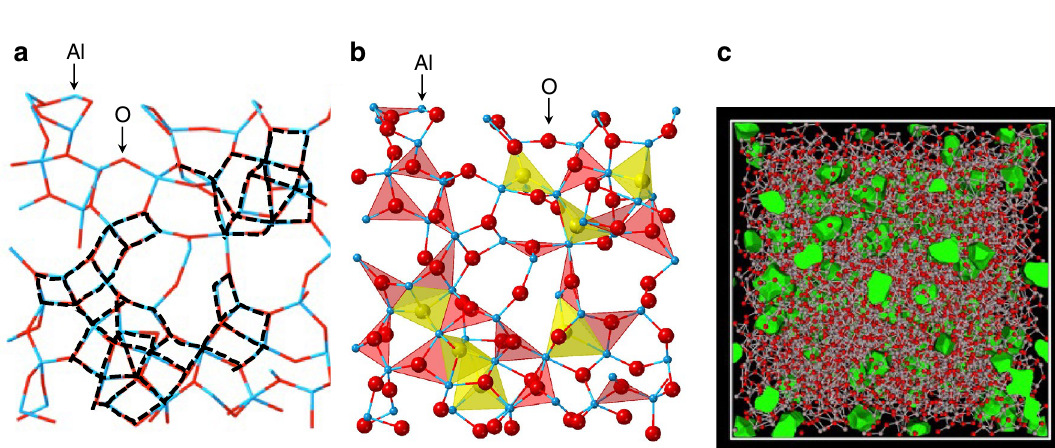
Figure 6. ( a ) Atomic configuration of g -Al 2 O 3 (stick bonds schematic). ( b ) Atomic configuration of g -Al 2 O 3 (schematic of the OAl 3 triclusters (red) and OAl 4 tetraclusters (yellow)). ( c ) Atomic configuration of g -Al 2 O 3 with voids. Pink and red circles represent Al and O atoms, respectively, and green regions show the